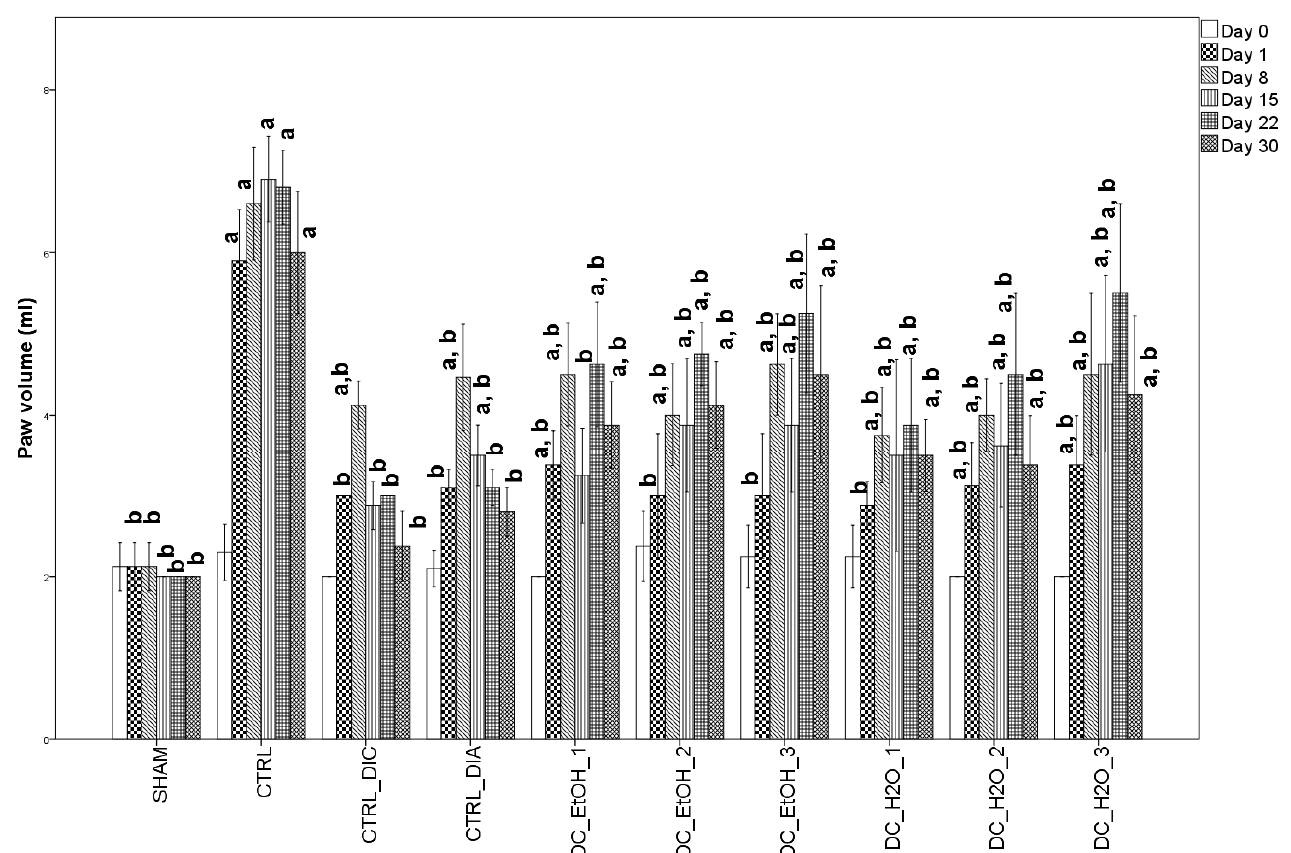
Figure 2. Effect of Dichrostachys cinerea water and ethanolic extracts on paw edema. Data are presented as means ± SD (n = 10 for each group). For comparison between groups, one-way analysis of variance (ANOVA) with Tukey multiple comparison tests were used. Superscript ‘a’ indicates a significant difference ( p < 0.05) as compared to the SHAM group while superscript ‘b’ indicates a significant difference ( p < 0.05) as compared to the CTRL group.